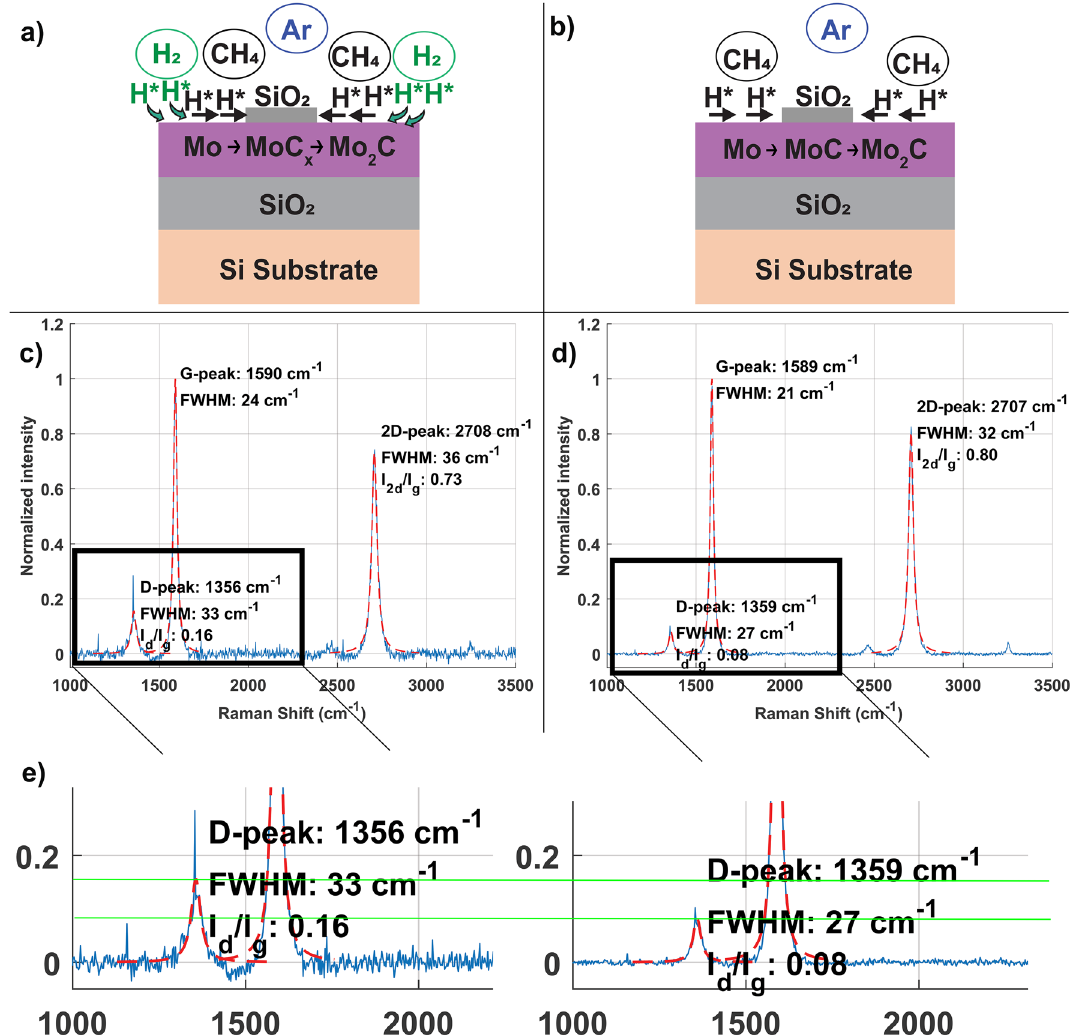
Figure 4. Schematic images showing the H spill-over during the CVD process for ( a ) standard CVD process, ( b ) CVD process in absence of external H 2 gas. Corresponding Raman spectra depicting the MLG growth for both samples given as ( c ) sample with H 2 gas in standard CVD process and ( d ) without, showing a difference in D peak. ( e ) Raman spectra zoomed in to D-peak region, comparing the I d /I g ratios of the two samples, where for clarification a guide to eye was added (green